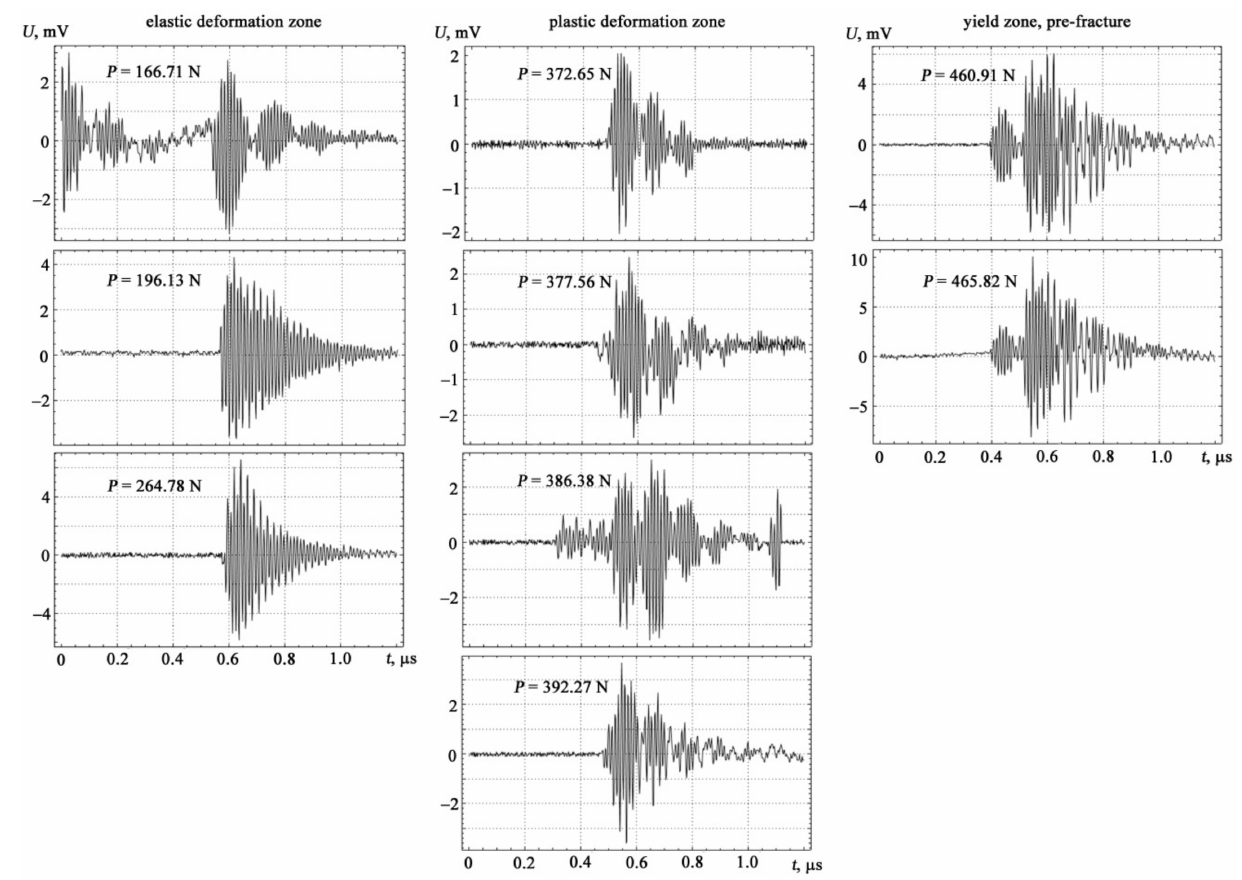
Figure 5. Experimental investigation of the form of acoustic emission signals under transverse bending